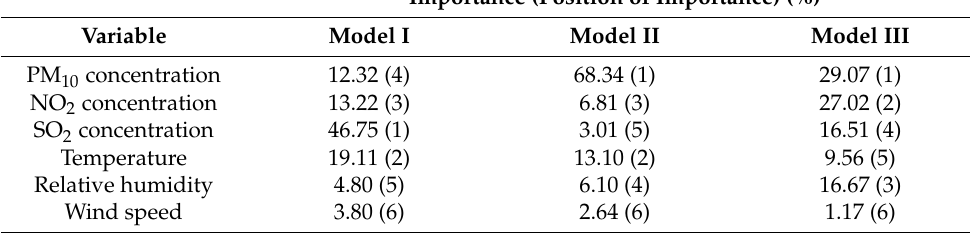
Table 1. Relative importance (%) of each variable for cardiorespiratory mortality. The importance is presented according to the three ANNs obtained: the first one considers all databases (Model I), the second considers only data from the rainy season (Model II), and the third considers the data from the dry season (Model